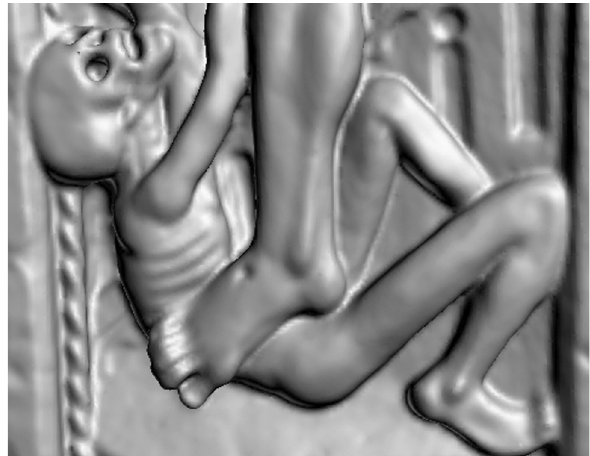
Figure 13: Cutout of a perron with resurrection scene after an original from Albrecht